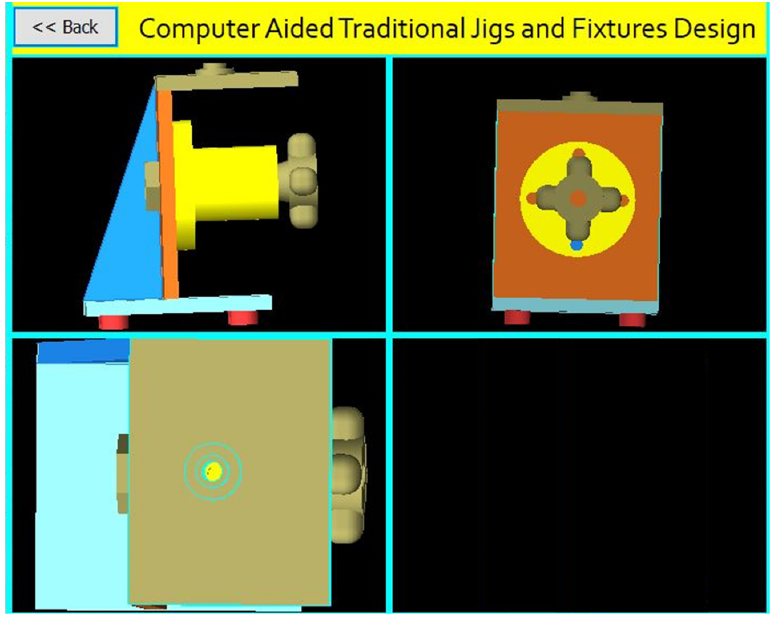
Figure 23. The jig views.